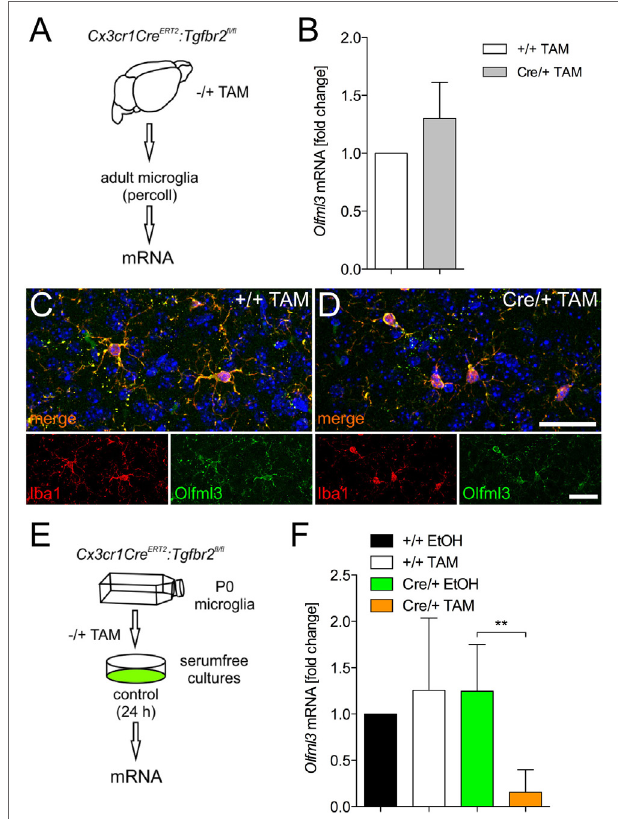
FigUre 3 | Identification of Olfml3 as a transforming growth factor β 1 (TGF β 1)-regulated gene. (a) Scheme illustrating the process of mRNA isolation from adult microglia of Cx3cr1 CreERT2 :Tgfbr2 fl/fl transgenic mutant mice. (B) Expression of Olfml3 in adult wild-type ( + / + TAM) and Tgfbr2 mutant microglia (Cre/ + TAM). Immunohistochemistry to monitor expression of Olfml3 in cortical microglia of wild-type ( + / + TAM) (c) and Tgfbr2 -deficient (Cre/ + TAM) mice (D) . Scale bars indicate 10 µm. (e) Scheme summarizing TAM-induced recombination and isolation of postnatal microglia in vitro isolated from P0/P1 mice. (F) Significantly decreased expression of Olfml3 in Tgfbr2 -deficient (Cre/ + TAM) postnatal microglia recombined in vitro . Data are presented as mean ± SEM from at least three independent experiments (B,F) . P -value derived from one-way ANOVA is ** P <